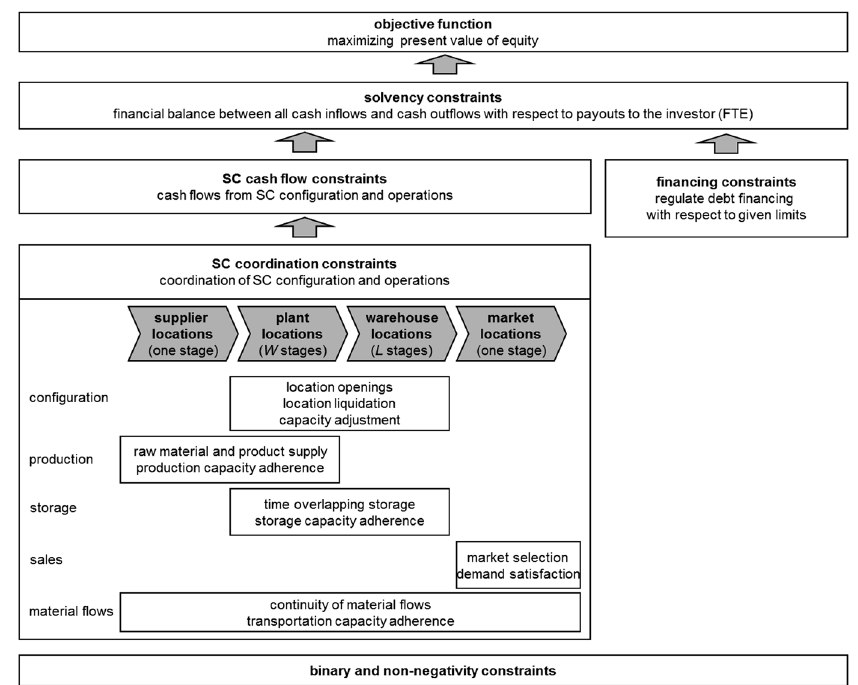
Fig. 2 Structure of the decision